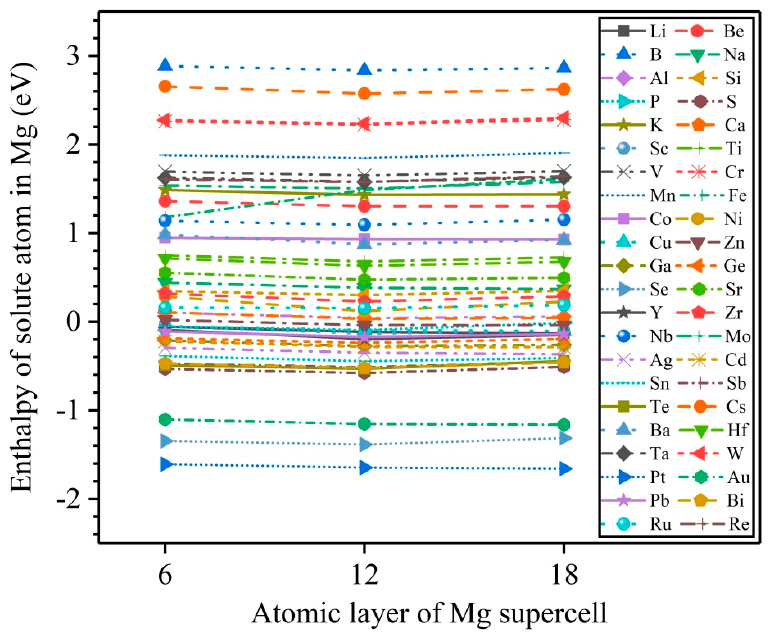
Figure 3. The calculated results of formation enthalpies of solute atoms in a 3 × 3 × L (L = 6, 12, 18) magnesium perfect supercell with one magnesium substituted by a solute.